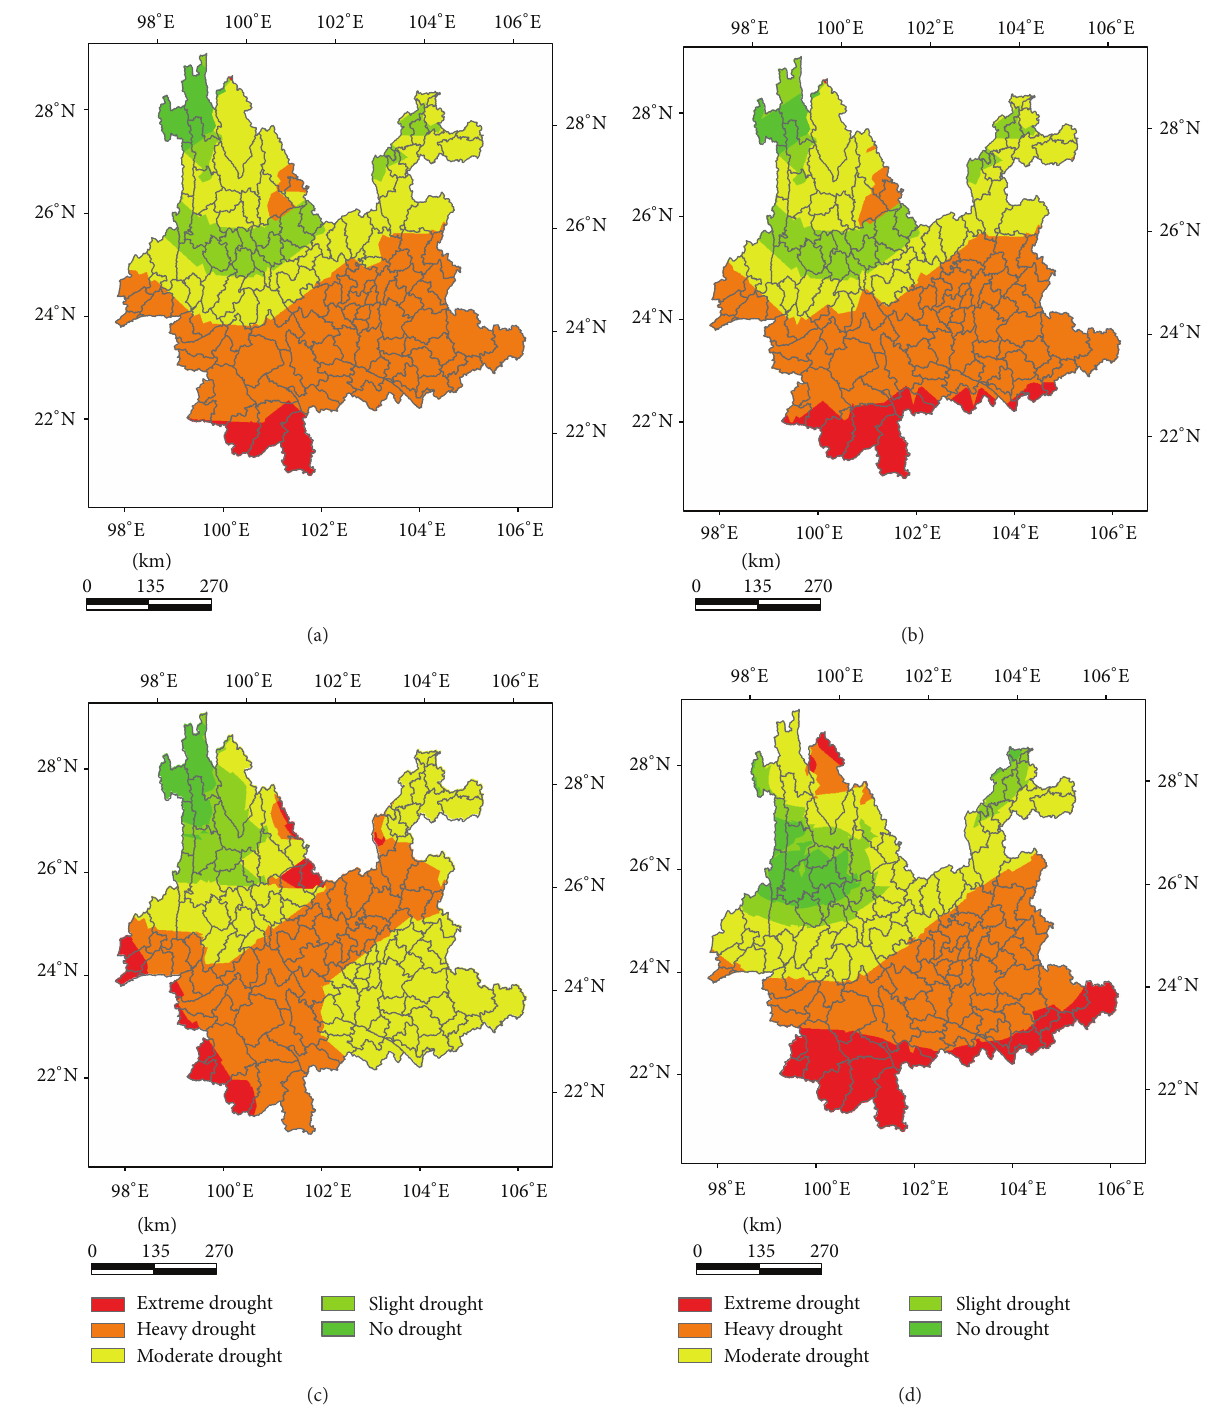
Figure 7: Spatial pattern of the risk of drought in Yunnan province during 2020–2050: (a) 2020; (b) 2030; (c) 2040; (d) 2050.